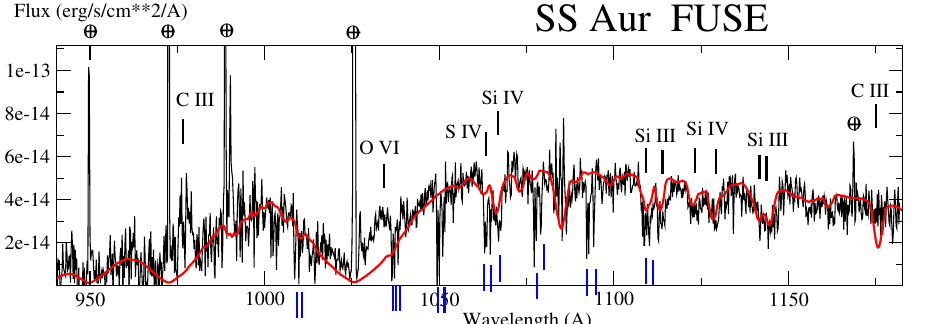
Figure 3. A WD model fit (solid red line) to the FUSE spectrum of SS Aur (black line) obtained at quiescence on 13 February 2002, 28 days after outburst. The sharp emission lines are geocoronal in origin. We identify broad emission lines from the O VI doublet ( ∼ 1032, 1038 Å), and C III (977 Å), not forming in the photosphere. Moderate ISM ( H 2 ) absorption lines are marked in blue. The absorption lines and emission lines of the sources are indicated above the spectrum. The WD fit yields T eff = 30,200 ± 500 K, Log ( g ) = 8.4 ± 0.1, M wd = 0.86 ± 0.07 M (cid:12) , V rot sin ( i ) = 400 ± 50 km/s, and a silicon abundance [Si] = 0.5 ± 0.1 solar. The other species were set to solar abundances. The C III (1175) absorption line is not observed, it could be filled up by emission.